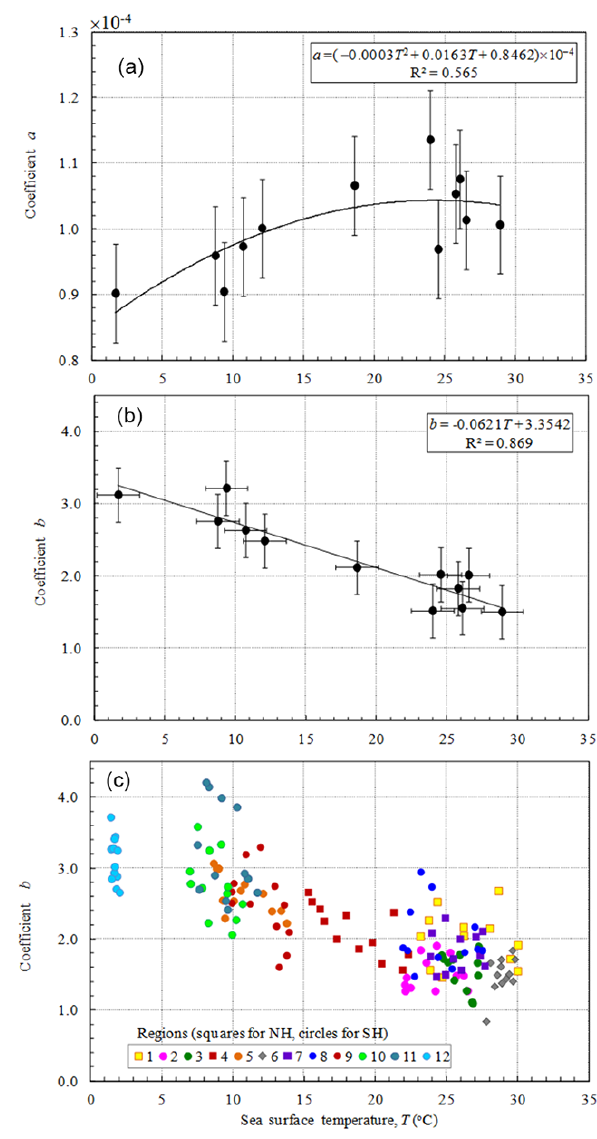
Figure 12. Sea surface temperature dependences of (a) coefficient a (slope) and (b) coefficient b (intercept) in the W(U 10 ) dependence. Each point is the annual mean for a different region. The error bars indicate ± 1 standard deviation for SST (horizontal bars) and coef- ficients (vertical bars). Panel (c) shows the monthly values of coef- ficients b for each region that form one data point in (b) . Regions in Northern Hemisphere (NH) are shown with squares; regions in Southern Hemisphere (SH) are shown with circles. The diamonds are for region 6 at the